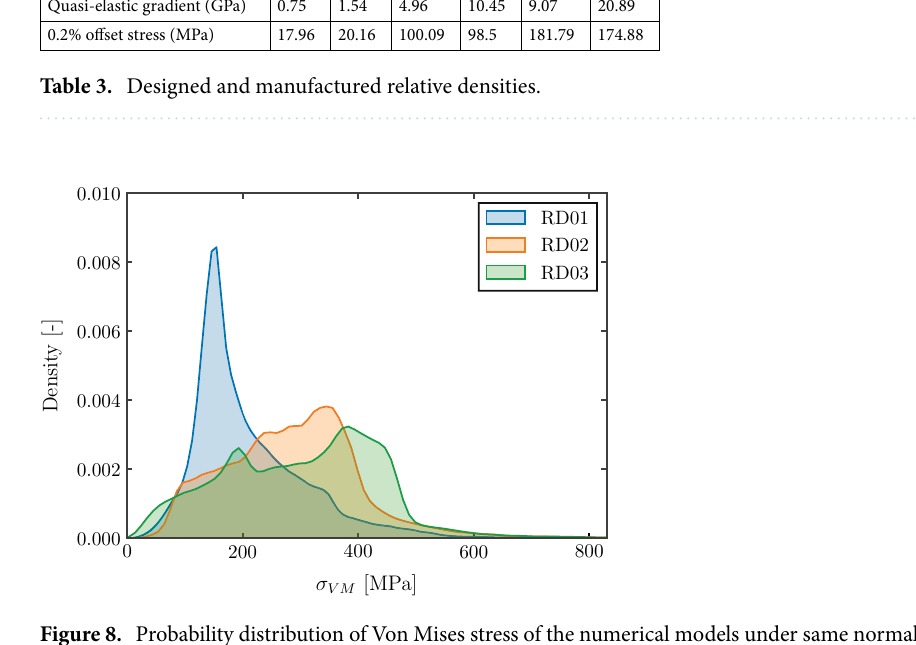
Table 3. The numerical model is capable of predicting the strength of the FCCm structures consistently, with a maximum relative error of 12% in the case of the RD01 structure. Nevertheless, the quasi-elastic gradients of the numerical models are far from the experimental values obtained. It is common to have significant differences between numerically and experimentally obtained mechanical properties of lattice structures, since numerical models neglect many imperfections that reduce the stiffness of lattices, and can even cause changes in their anisotropy 38,39 . These imperfections include the dross formation, the waviness of struts, the surface roughness, internal porosity, among others, and were not considered in the numerical models.